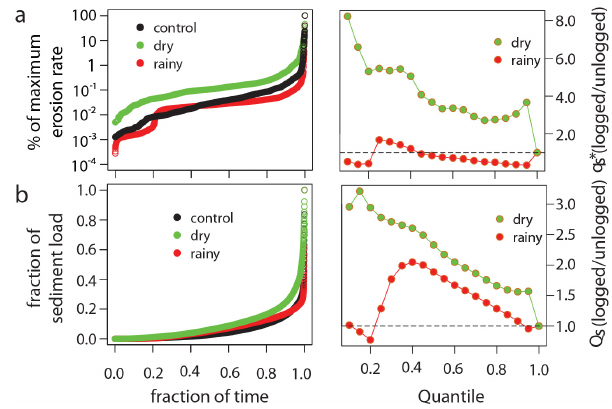
Figure 5. (a) Fraction of instantaneous sediment transport rates normalized to catchment maximum as a function of monitoring time during which these rates were not exceeded. (b) Fraction of total sediment load normalized per catchment as a function of the frac- tion of total monitoring period for unlogged conditions as well as rainy- and dry-season logging. Right-hand panels show resulting Figure 7. QRF model results of SSC dynamics during extreme ratios of instantaneous transport rates q ∗ and total sediment loads s peak flow for undisturbed and logged conditions during two rain- Q s per quantile for logged versus unlogged conditions. Black hori- fall events, i.e. 15–18 August 2010 (a–c) and 26–28 August 2010 zontal dashed lines are 1 : 1 ratio. Empirical cumulative distribution (d–f) . Density of SSC predictions of the QRF model for each time functions di ff er significantly ( p < 0.01, Kolmogorov–Smirnov test). step encoded by grey histograms, black dashed lines are means of these predictions, and green dashed lines are SSC predictions based on SRCs. In (c) , red crosses show measured